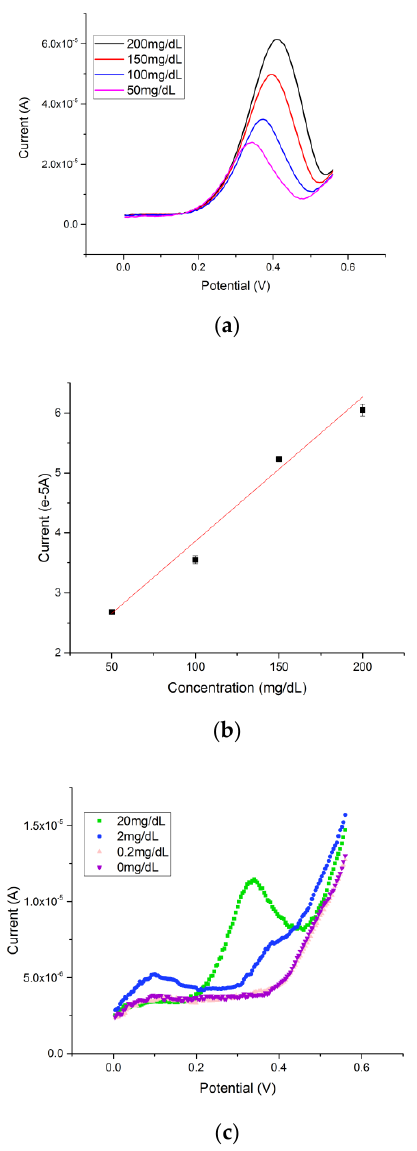
Figure 4. ( a ) Differential pulse voltammetry (DPV) measurements of glucose concentrations ranging from 200 mg/dL to 50 mg/dL; ( b ) Calibration linear relationship of DPV current outputs and concentrations of glucose; ( c ) Detection limit of the cuprous oxide sensor by using DPV was 0.2 mg/dL.